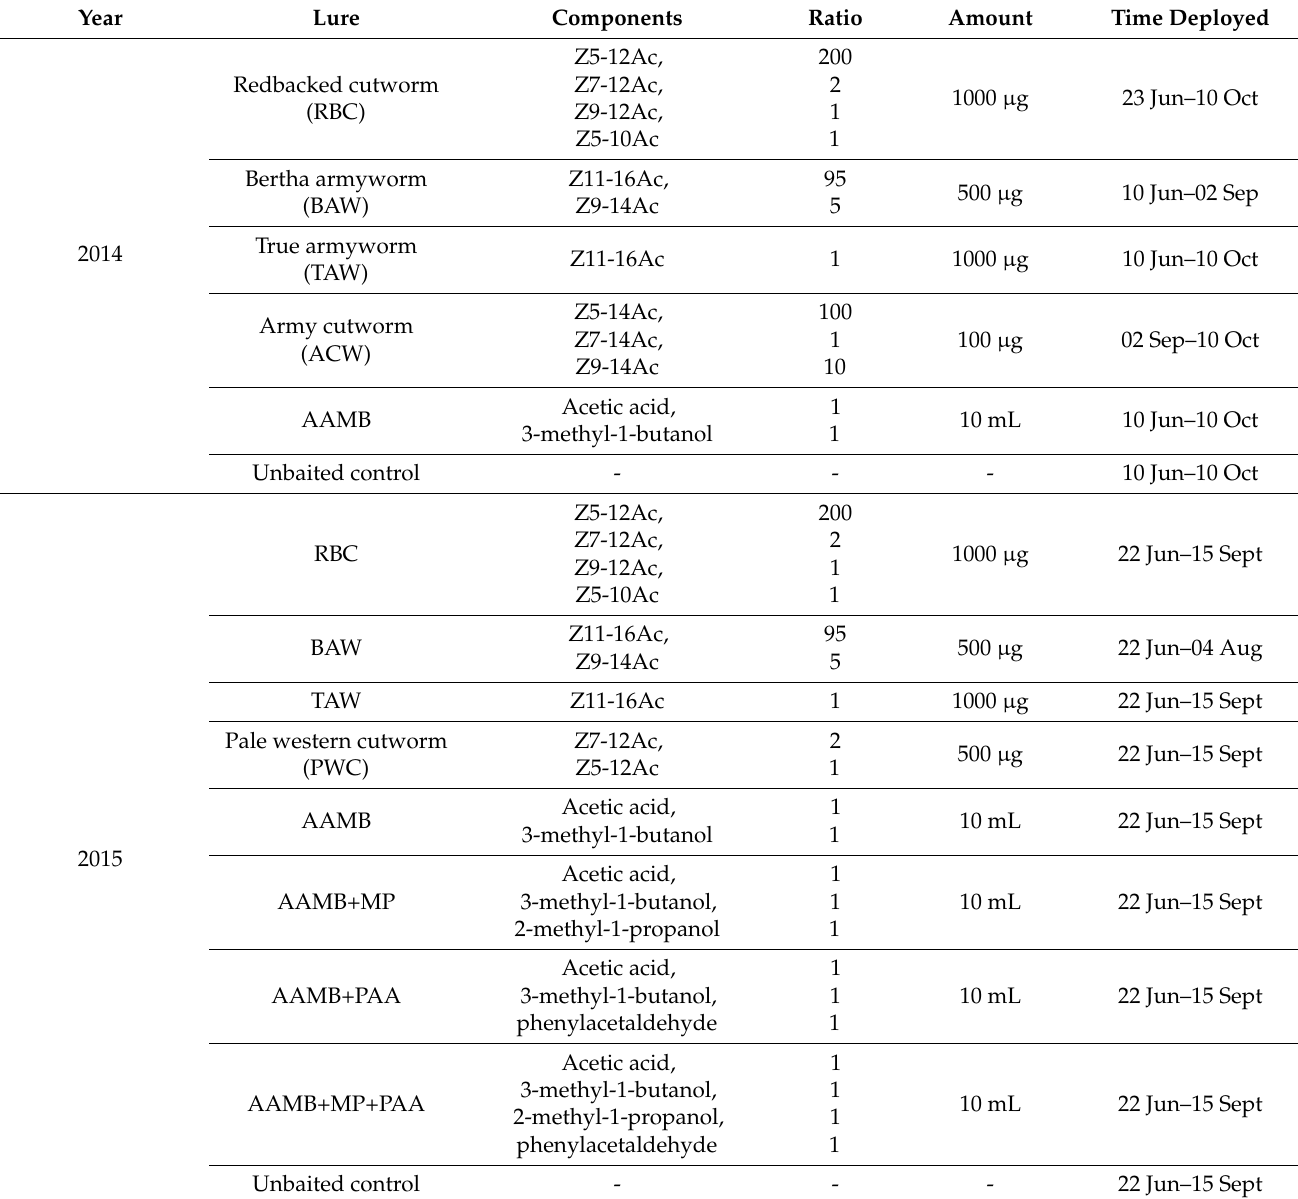
Table 1. Lure composition and deployment schedule for moth monitoring field